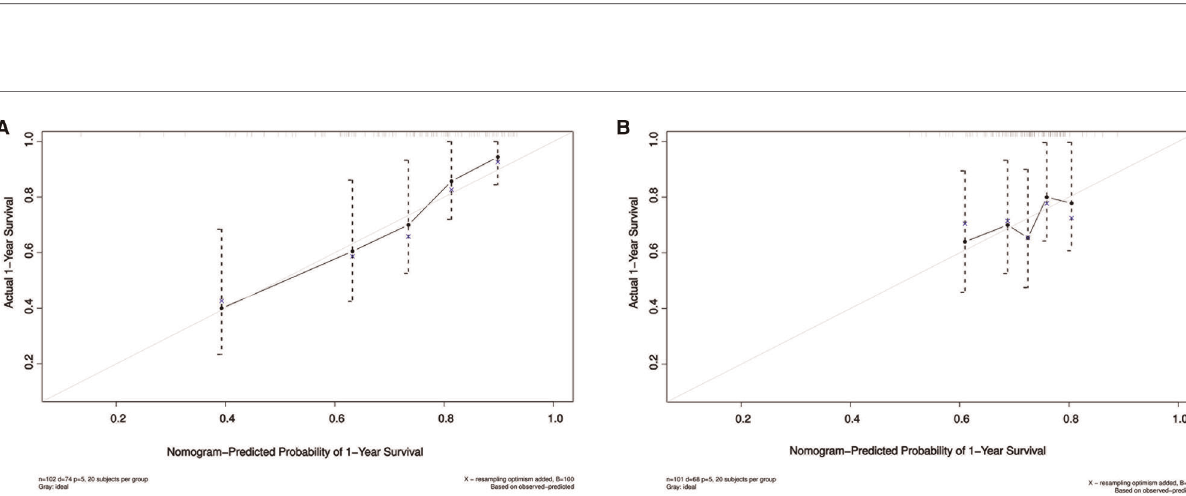
FIGURE 1 | A nomogram for prediction of 1-year mortality after arthroplasty in nonagenarians with hip fractures. aCCI, age-adjusted Charlson Comorbidity Index; ASA classi fi cation, American Society of Anesthesiologists classi fi cation; Ca 2+ , serum calcium; HGB, hemoglobin.